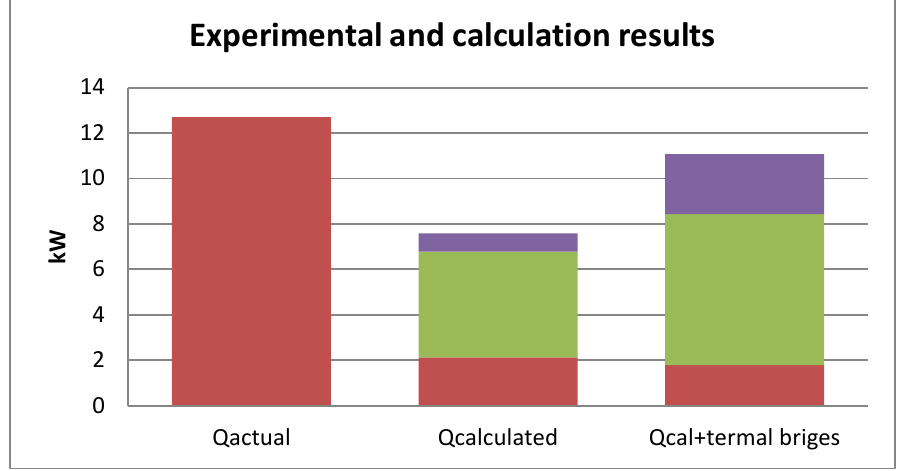
Figure 9. Comparison of heat loss during the experiment, results of determined and theoretical calculations